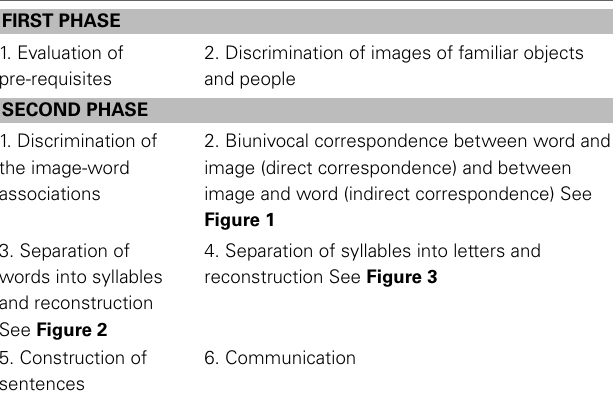
Table 3 | Training about reading-writing